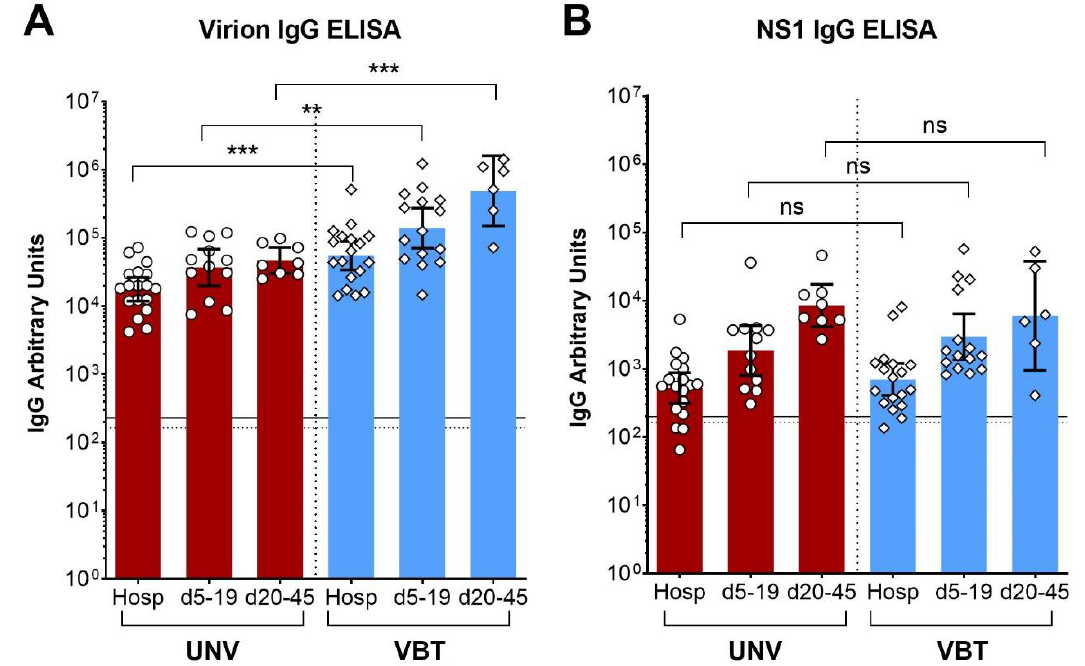
Figure 2. TBE virion- and NS1-specific IgG antibody responses of unvaccinated (UNV) and vaccination breakthrough (VBT) TBE patients in ELISA. ( A ) Virion-specific and ( B ) NS1-specific IgG antibody responses of TBE patients with and without prior vaccination, each group comprising 18 patients. Hosp represents samples obtained upon hospitalization. d5–19 and d20–45 are follow-up samples obtained 5 to 19 days and 20 to 45 days after the first serum, respectively. Data represent geometric means with 95% confidence intervals. The significance of changes in antibody concentrations between the two groups in the different time windows was determined by t -tests. ns, not significant; **, p < 0.01; ***, p < 0.001. Cut-off positive: solid line, cut-off equivocal: dashed line. Hosp, hospitalization; UNV, unvaccinated; VBT, vaccination break- throughs. Table 3. Statistical evaluation of the increase in the mean TBE virion- and NS1-specific IgG antibody responses at different time points after hospitalization (Figure 2).